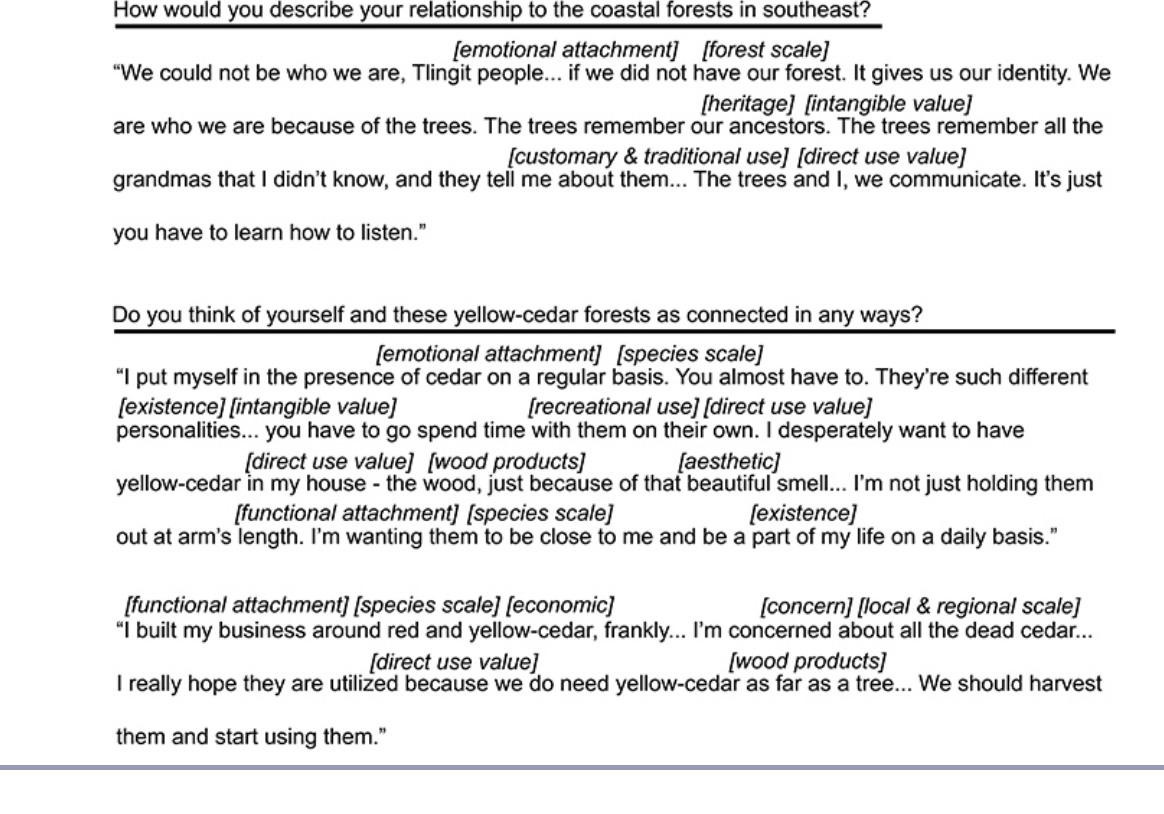
Fig. 2 . Examples of overlapping content in responses. Quotations are in regular type. The coded use values, attachment, and attitudes are bracketed in italics above the occurrence.